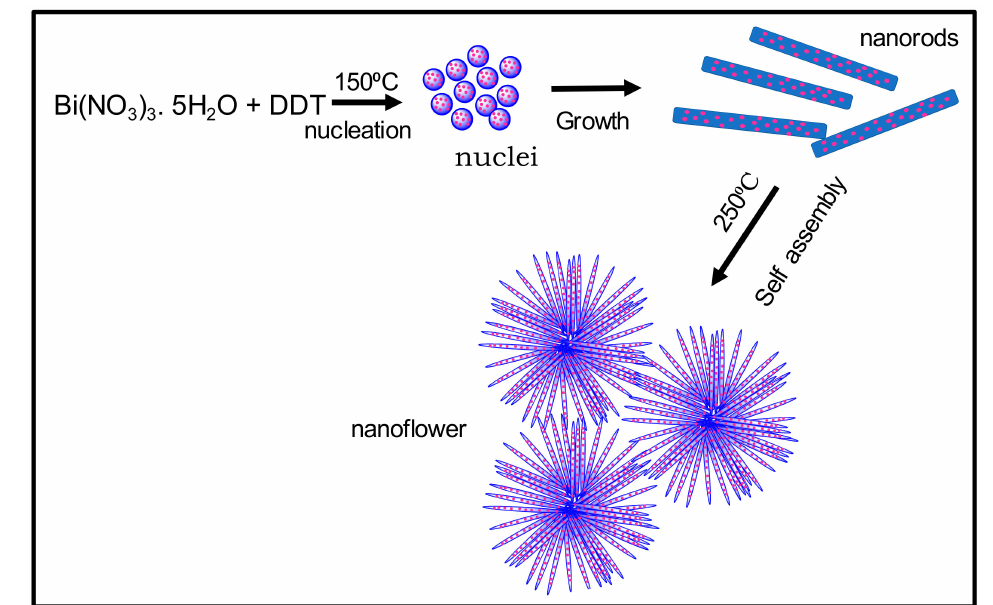
Figure 1. Schematic diagram for the synthesis and growth of Bi 2 S 3 nanorods and nanoflowers. DDT-1-docanethiol